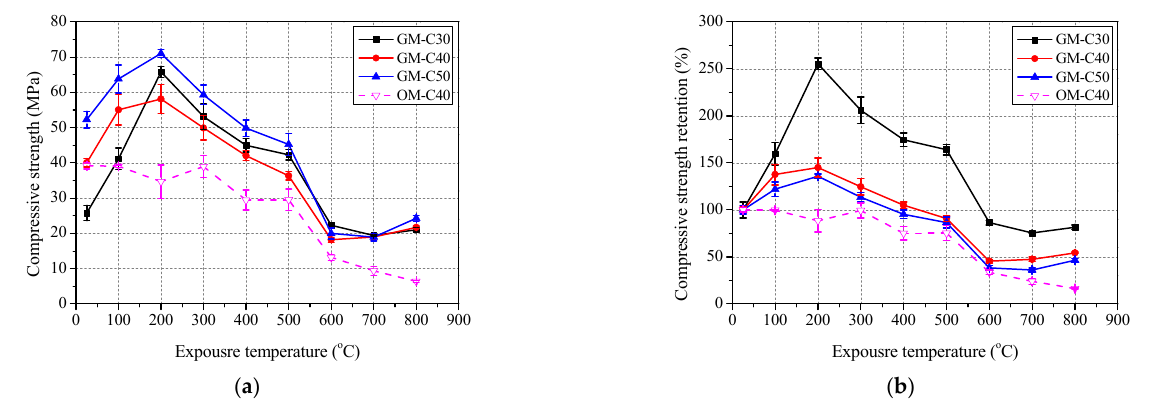
Figure 11. Residual compressive strength of mortar after exposure to elevated temperature: ( a ) compressive strength and ( b ) retention. Table 5. Tested compressive strength of mortar and paste